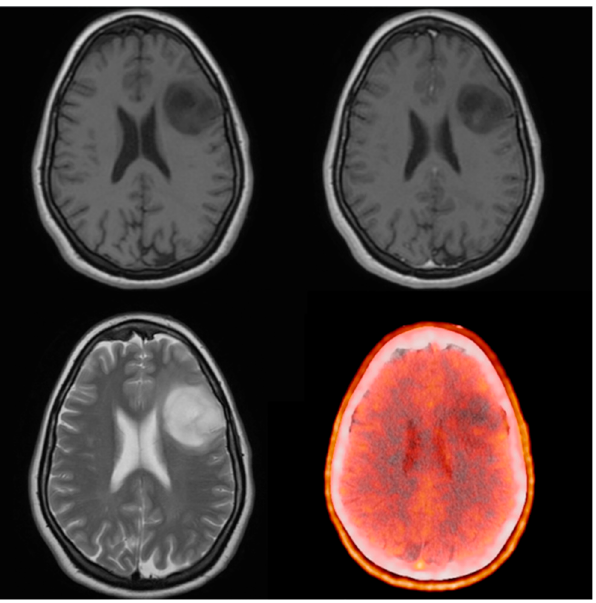
Figure 3. Thirty-one-year-old female, presenting with epileptic seizure. MRI showed a non-enhancing lesion in the left frontal operculum. On PET/CT the tumor was photopenic (SUVmax: 1.5 vs. 1.8, TBRmax: 0.8). Due to misinterpretation, the lesion was handled as low grade. First, a follow-up MRI made after 120 days already showed slight enhancement in the cranial part of the tumor.